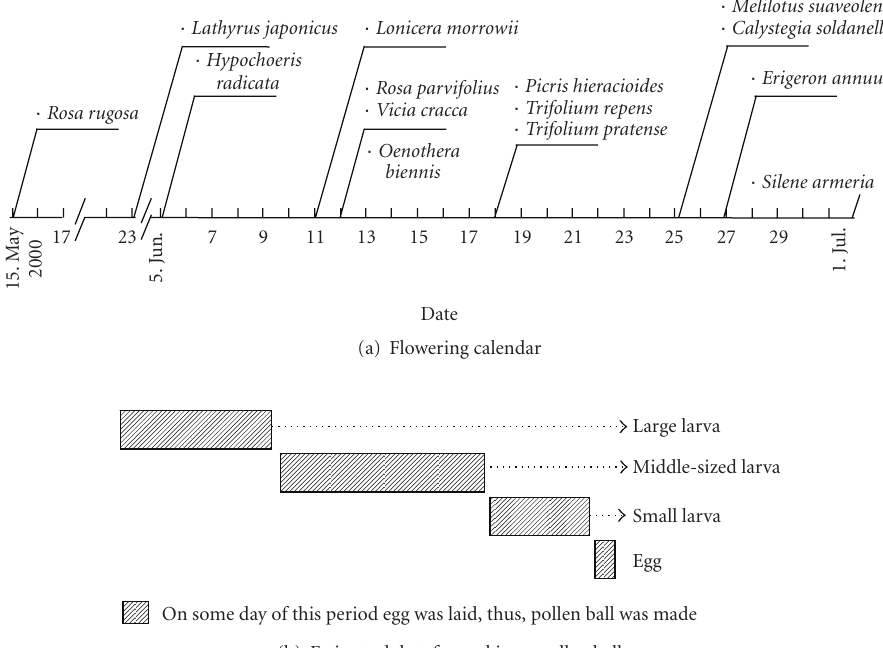
Figure 2: (a) Flowering phenology on the Isikakri Coast and (b) oviposition dates (i.e., dates when pollen balls were made) inferred from the rearing of immature individuals in the laboratory. Nests with pollen balls, eggs, larvae, pupae, and adults were sampled on 1 July. The thick line in (a) represents the starting dates of the flowering period of each flowering species at the field. The date axis in (a) is common with in (b). Table 3: Weight (mg) of desiccated pollen per flower head on each day after the initiation of flowering (see Figure 2(a) for each species). Mean ± standard deviation of five flower heads. Average pollen production ( P ) was used to calculate pollen availability within a 50 × 100 m quadrat (cf. Table 4). Names of flowering species are arranged in descending order average pollen production. Flowering